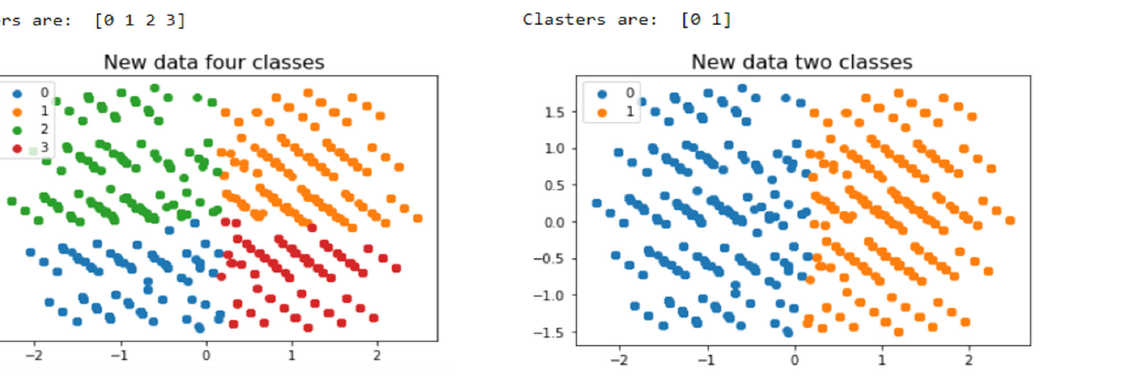
Fig. 17. The reduced dataset format was divided into two classes